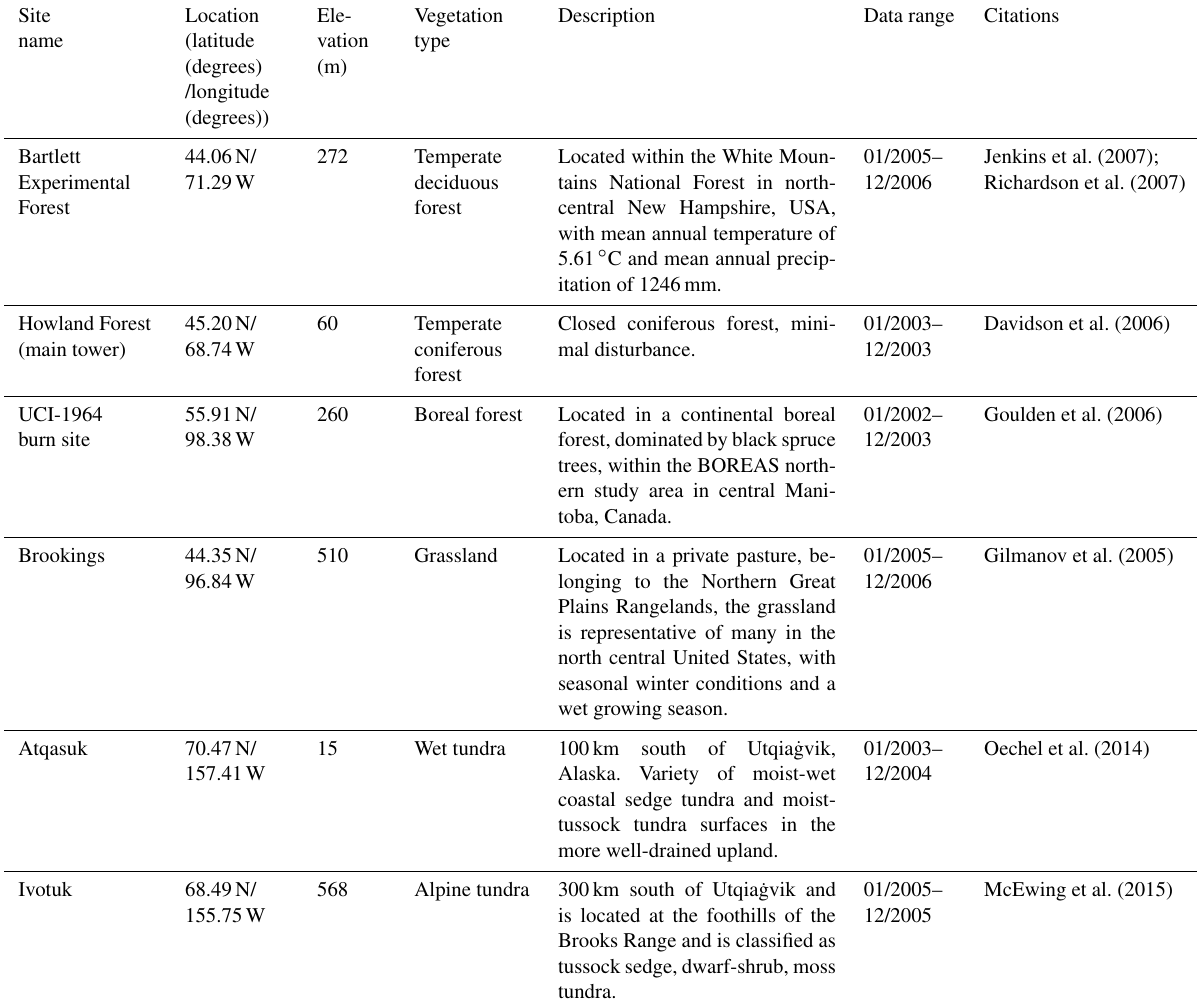
Table 3. Site description and measured NEP data used to validate MIC-TEM-dormancy.